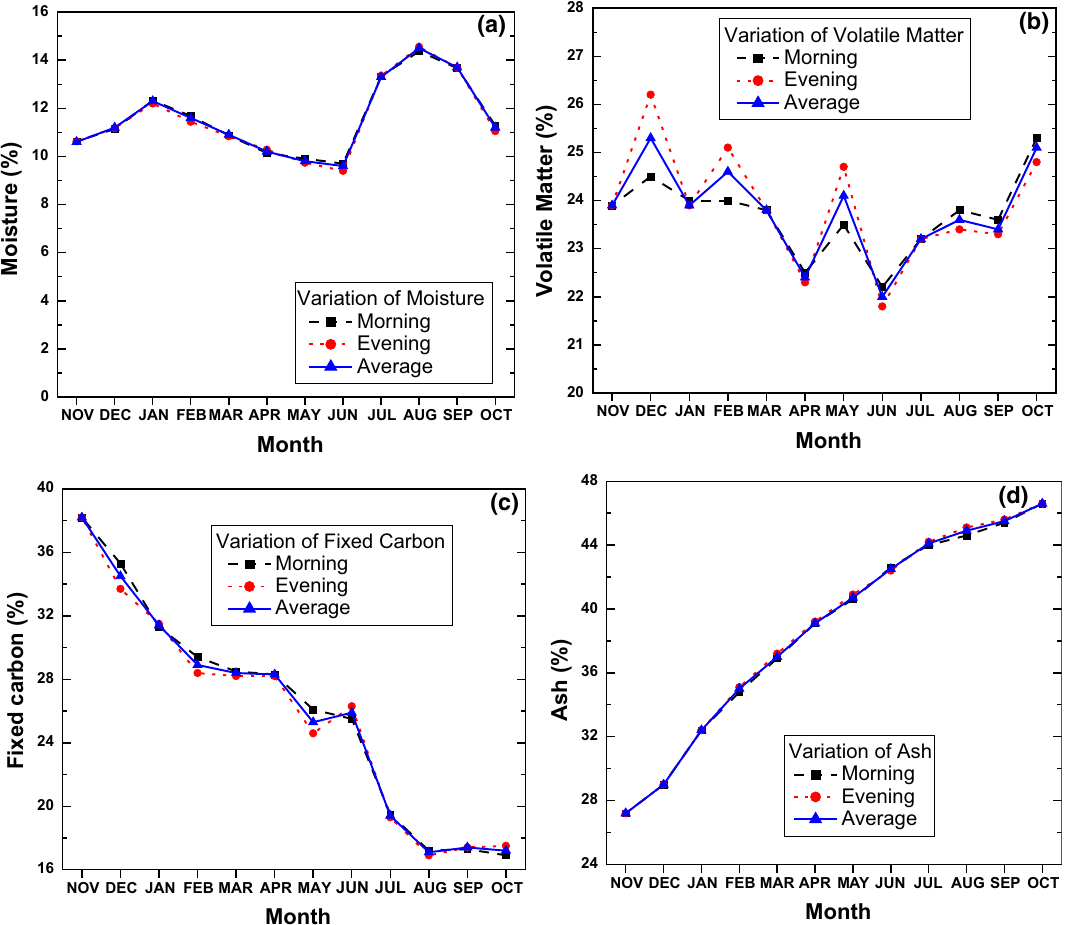
Fig. 2 Variation of a moisture, b volatile matter, c fixed carbon, d ash due to weathering (on as received